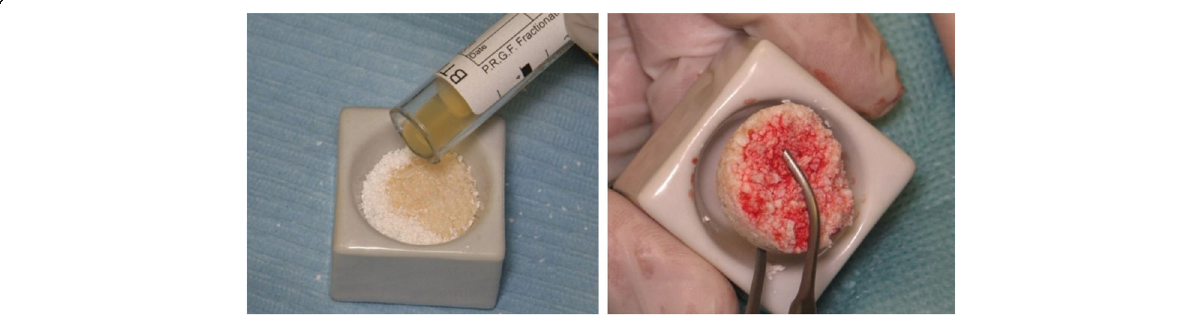
Fig. 2 PRGF is mixed with DBB ( a ) and after a few minutes the mixture attains a viscous consistency facilitating easy handling of the bone substitute particles ( b